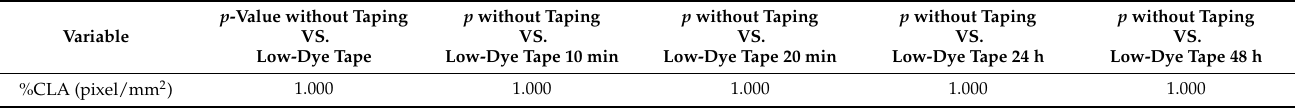
Table 6. Statistical significance comparing results without taping with results over time in the variable studied. p -Value without Taping p without Taping p without Taping p without Taping p without Taping Variable VS. VS. VS. VS. VS. Low-Dye Tape Low-Dye Tape 10 min Low-Dye Tape 20 min Low-Dye Tape 24 h Low-Dye Tape 48 h %CLA (pixel/mm 2